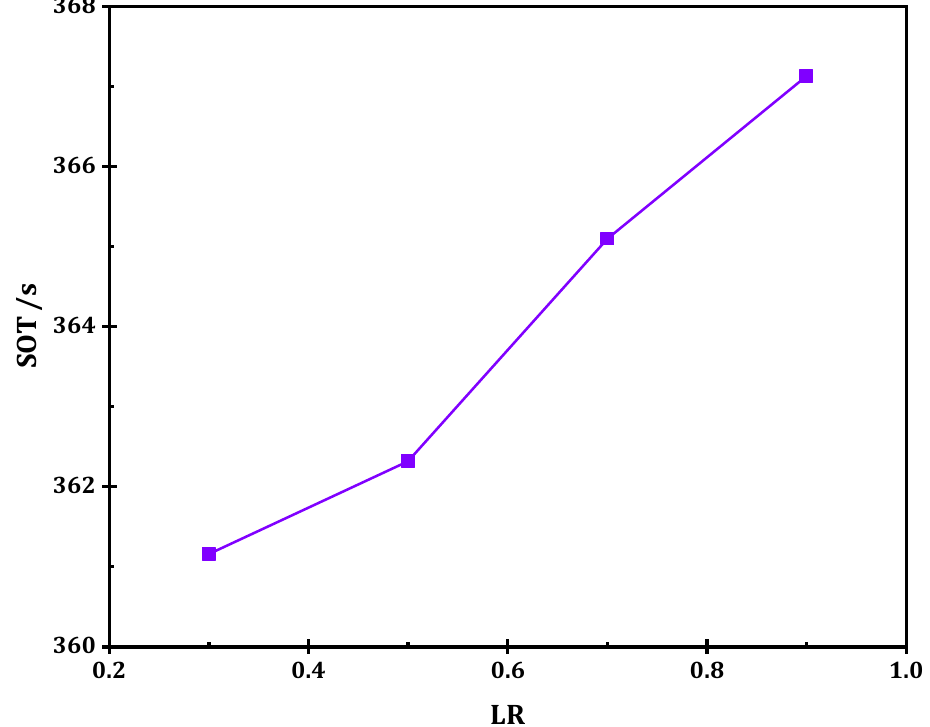
Figure 5. The effect of increase in length ratio (LR) on SOT ( H = 10 mm, three horizontal fins ( n = 3), AR = 1).